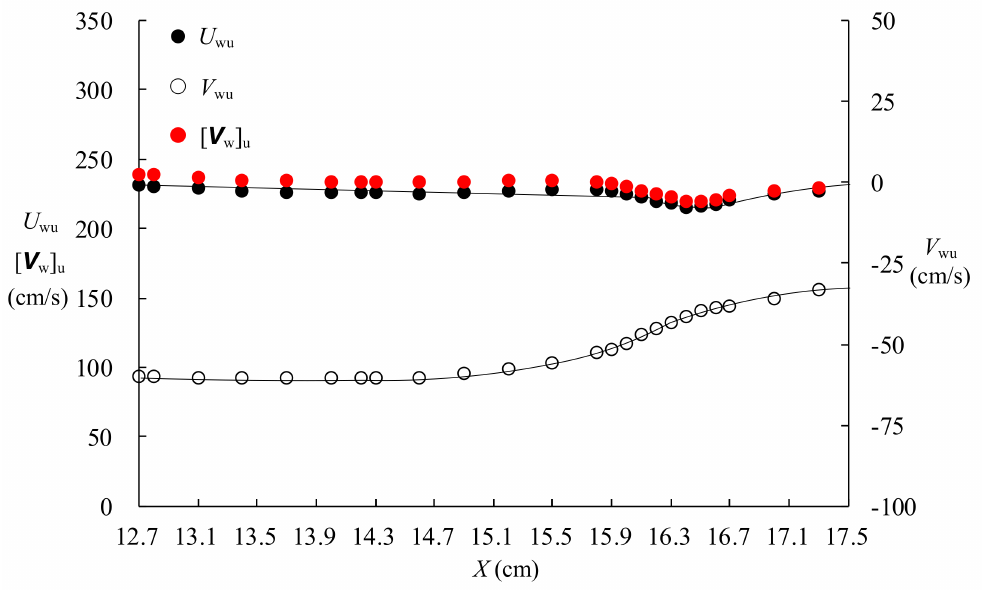
Figure 22. Variations of U wu , V wu and [ V w ] u against X